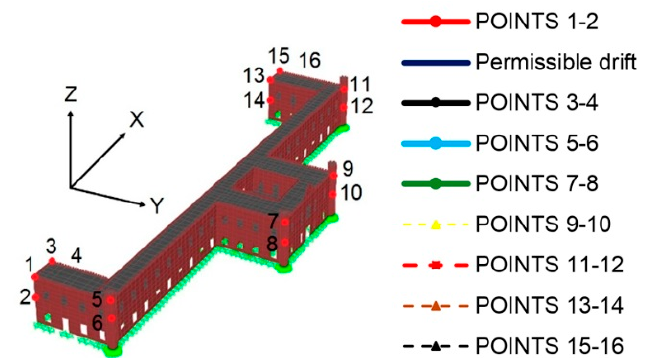
Figure 11. Seismic displacement and distortion measuring points by level.